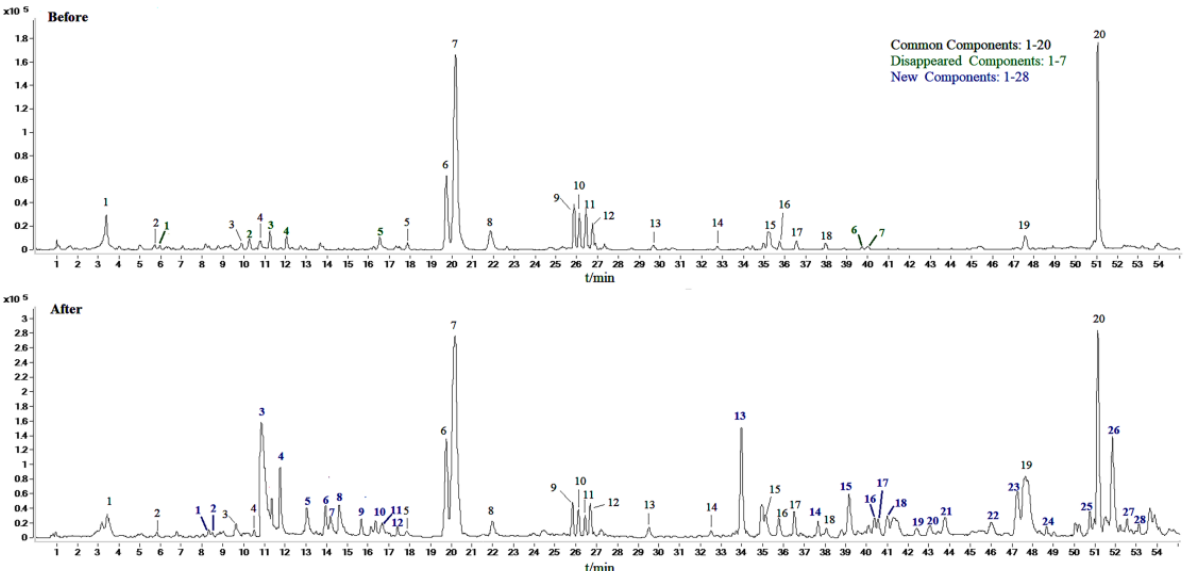
Figure 1. Negative-ion chromatogram of Sanguisorba officinalis L . before ( Sraw ) and after ( Sprocessed ) processing.